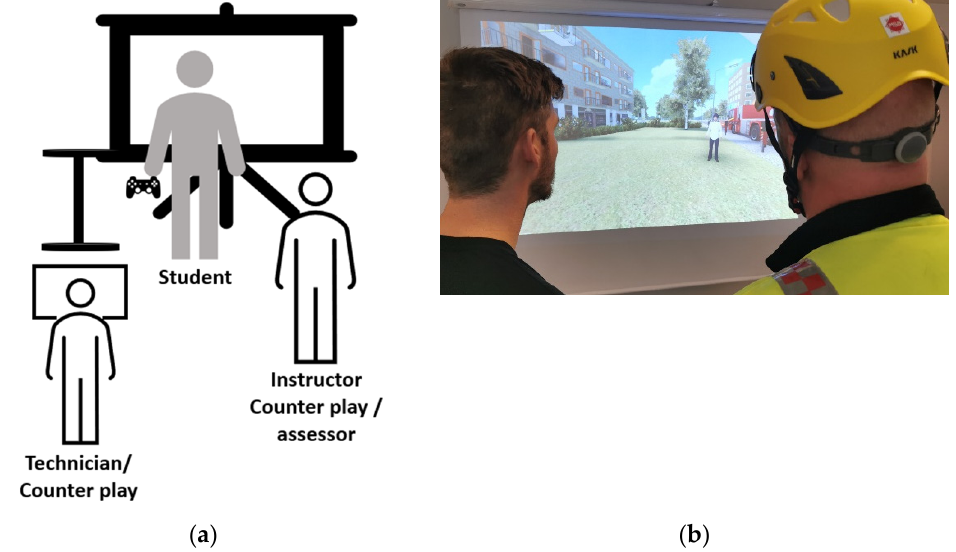
Figure 5. A schematic picture of the setup ( a ) and actual use ( b ) for VS on-site.